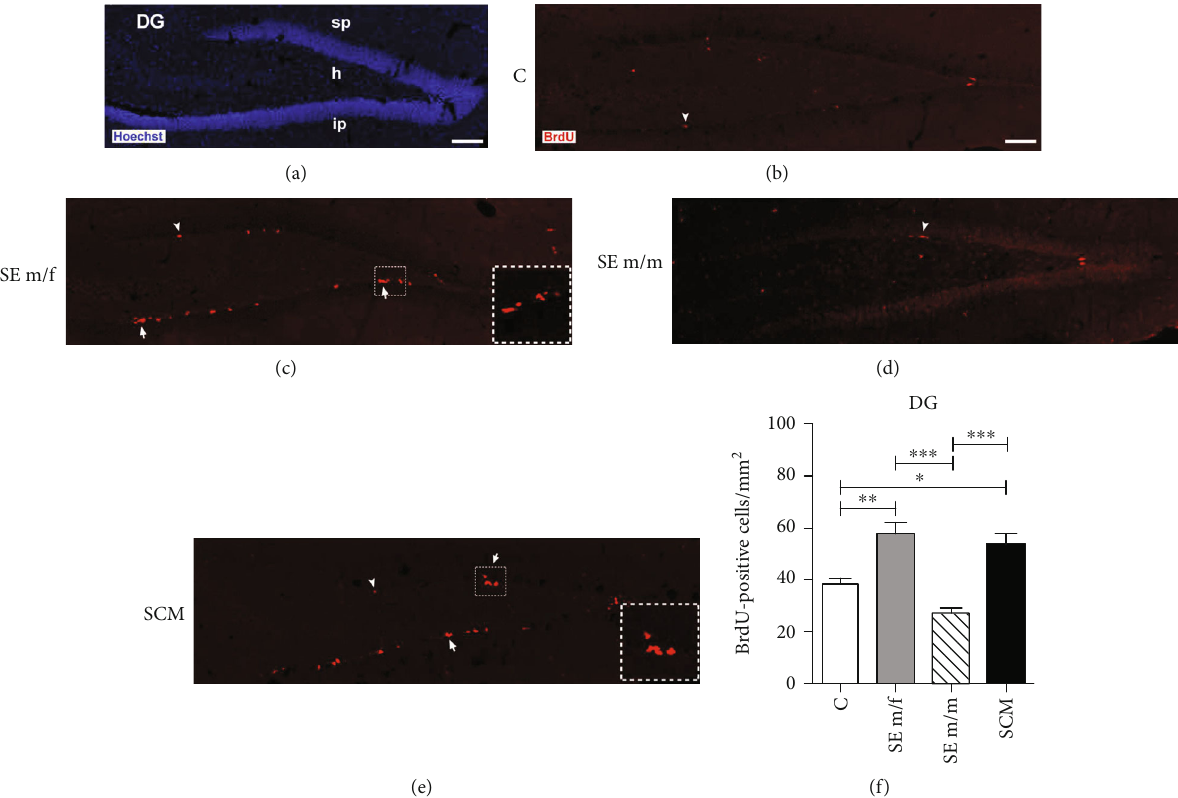
Figure 6: Photomicrographs of nuclei stained with Hoechst showing DG of the hippocampus in the male vole brain (a). Immunolabeling for BrdU in the DG from the control (C), social exposure to a female (SE m/f), social exposure to a male (SE m/m), and social cohabitation with mating (SCM) animals, respectively (b – e). White arrowheads point to single BrdU-positive cells, and white arrows indicate clusters of BrdU-positive cells. Scattered squares represent enlargements of the inserts at 20x, which show clustering of proliferating cells in the DG from the SE m/f and SCM voles. Data analysis for cell proliferation in the whole DG, including the hilus, for the C, SE m/f, SE m/m, and SCM animals (f). Data were analyzed with one-way ANOVA followed by Bonferroni ’ s post hoc tests. sp: suprapyramidal blade; ip: infrapyramidal blade; h: hilus. 20x. Scale bar: 100 μ m. ∗ p < 0 : 05 , ∗∗ p < 0 : 01 , and ∗∗∗ p < 0 : 001 . Results of ANOVA analyses are provided in the text. C ( n = 8 ), SE m/f ( n = 10 ), SE m/m ( n = 5 ), and SCM ( n = 9